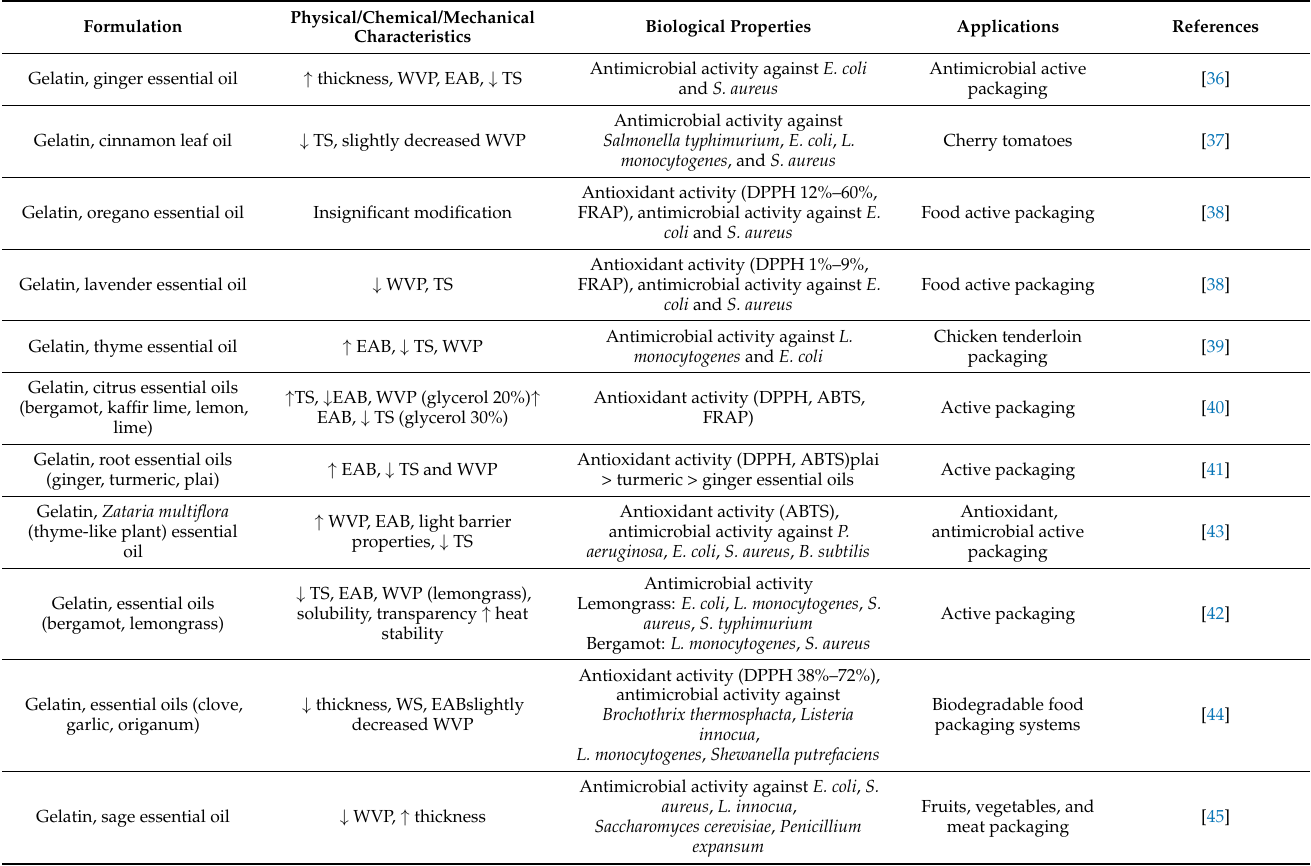
Table 3. The characteristics of gelatin–essential oil